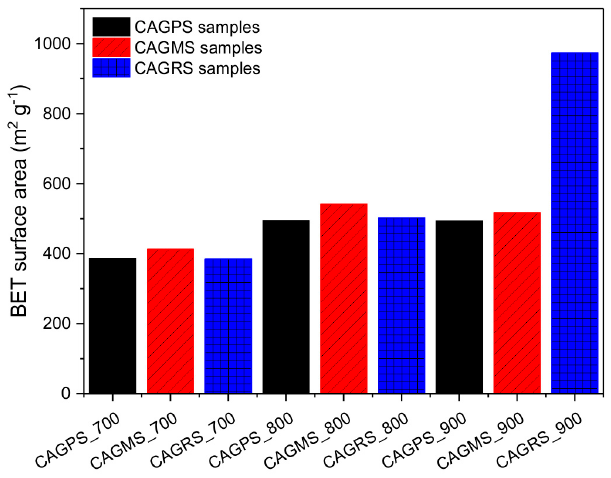
Figure 6. BET surface area of carbon aerogels.